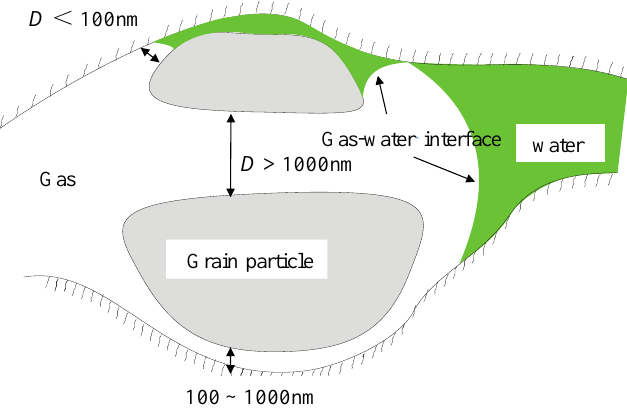
Figure 13. Schematic of flowback of water phase in shale multiscale pore structure.